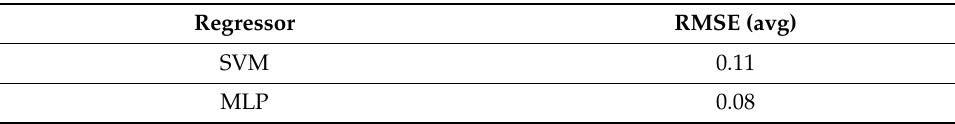
Table 4. RMSE for Table 4. RMSE for regression.